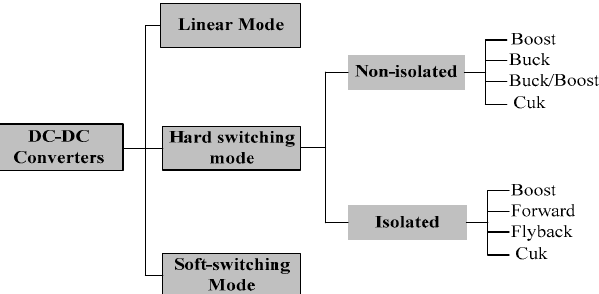
Figure 29. Classification of DC-DC converters.